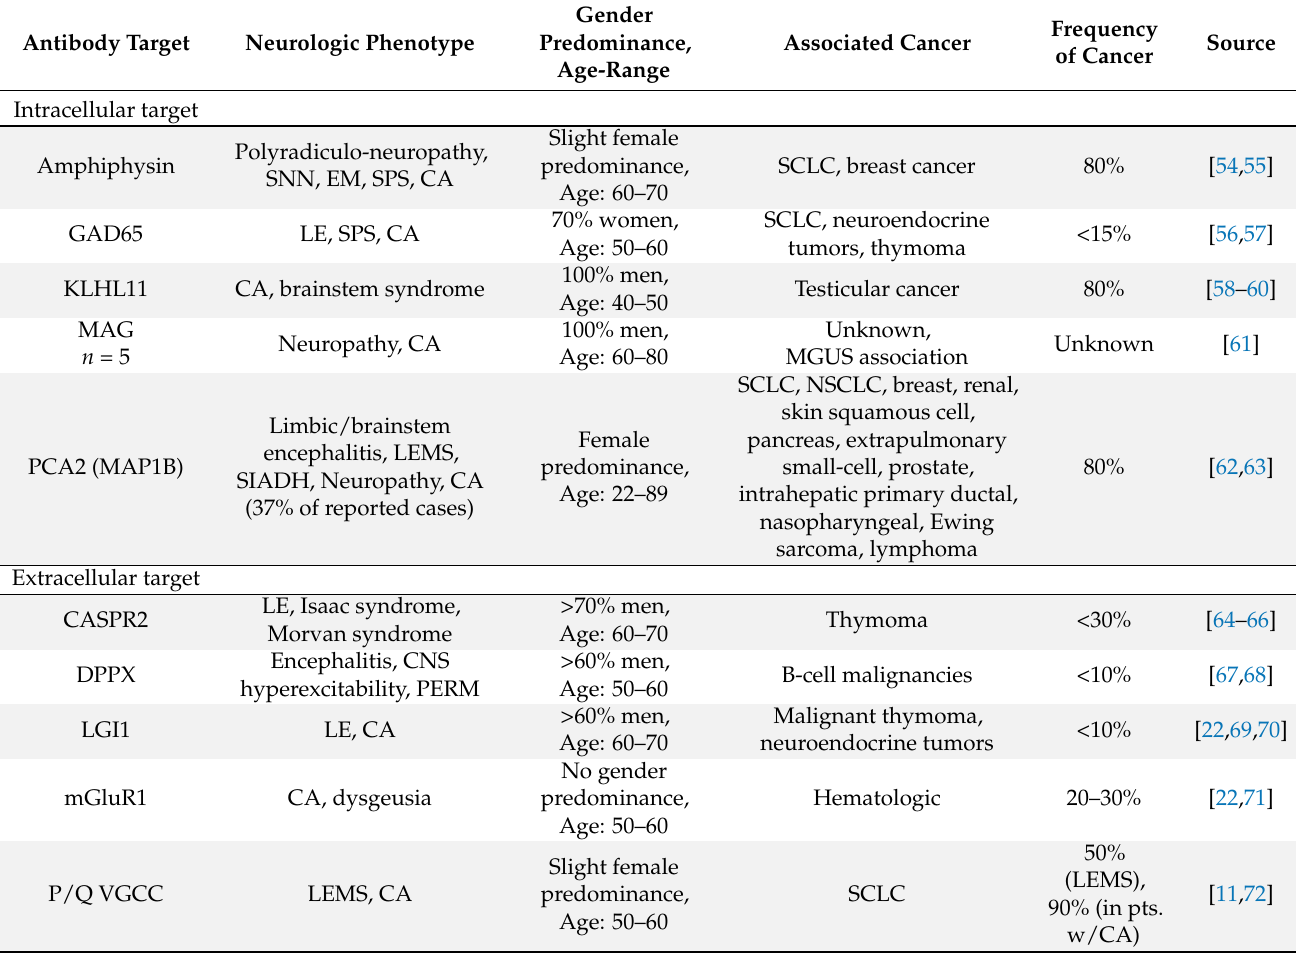
Table adopted from Mitoma et al. and Graus et al. [1,6]. Abbreviations: CASPR2: contactin-associated protein-like 2; DPPX: dipeptidyl peptidase-like protein; GAD65 : glutamic acid decarboxylase, KLHL11 : Kelch-like protein 11; MAG : myelin-associated glycoprotein; mGluR1: metabotropic glutamate receptor 1; PCA2 : purkinje cell antibody 2; VGCC: voltage-gated calcium channel CA: cerebellar ataxia; CNS: central nervous system; EM: encephalomyelitis; LE: limbic encephalitis; LEMS: Lambert-Eaton myasthenic syndrome; NSCLC: non-small-cell lung cancer; OMS: opsoclonus myoclonus syndrome; PERM: progressive encephalomyelitis with rigidity and myoclonus; SCLC: small-cell lung cancer; SPS: stiff-person syndrome; SSN: subacute sensory